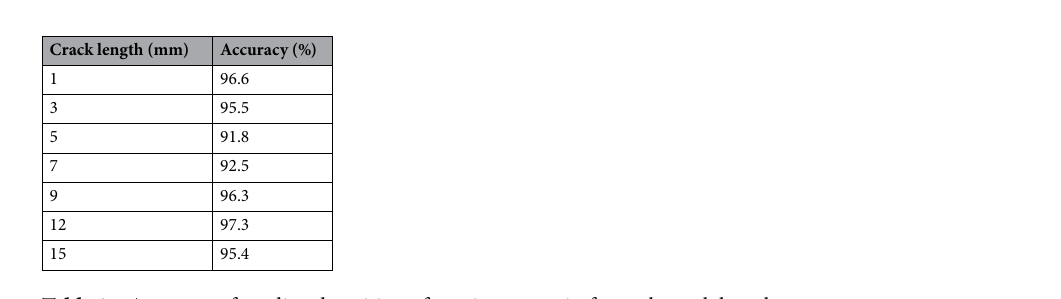
Table 2. Accuracy of predicted position of maximum strain for each crack